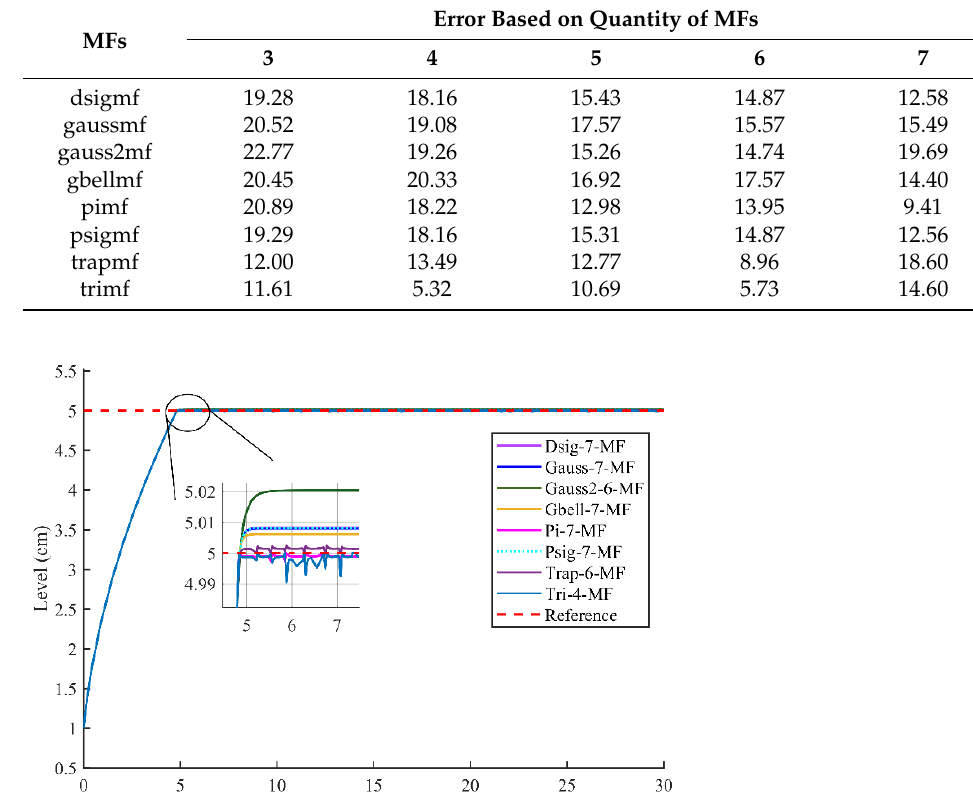
Figure 10. Membership functions at the input of ANFIS.